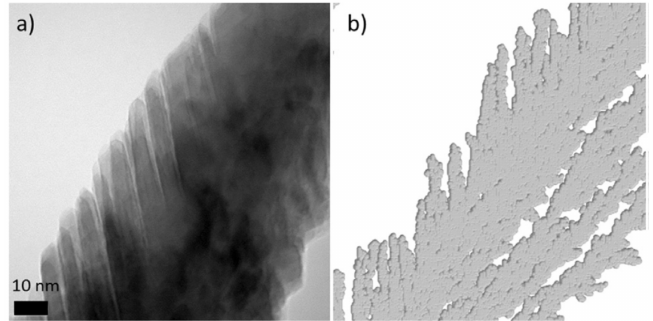
Figure 13. ( a ) Transmission electron microscopy (TEM) image of a Ti micro-column constituted by nano-columns from a Ti thin film synthesized at 0.13 Pa, 150 W, and 85 ◦ ; ( b ) the corresponding kMC simulation where each atom is represented by its covalent radius (reproduced from [50] with permission from Elsevier,